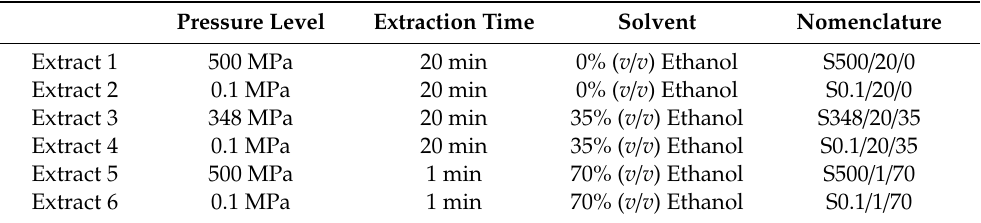
Table 1. Identification of extracts according to the conditions of pressure, extraction time, and ethanol concentration used as a solvent to perform